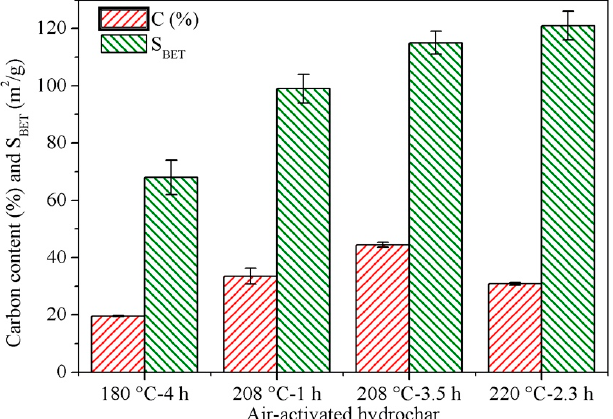
Figure 4. Carbon content on an ash-free basis and surface area ( S BET ) of hydrochars air-activated at 325 °C for 2 h.